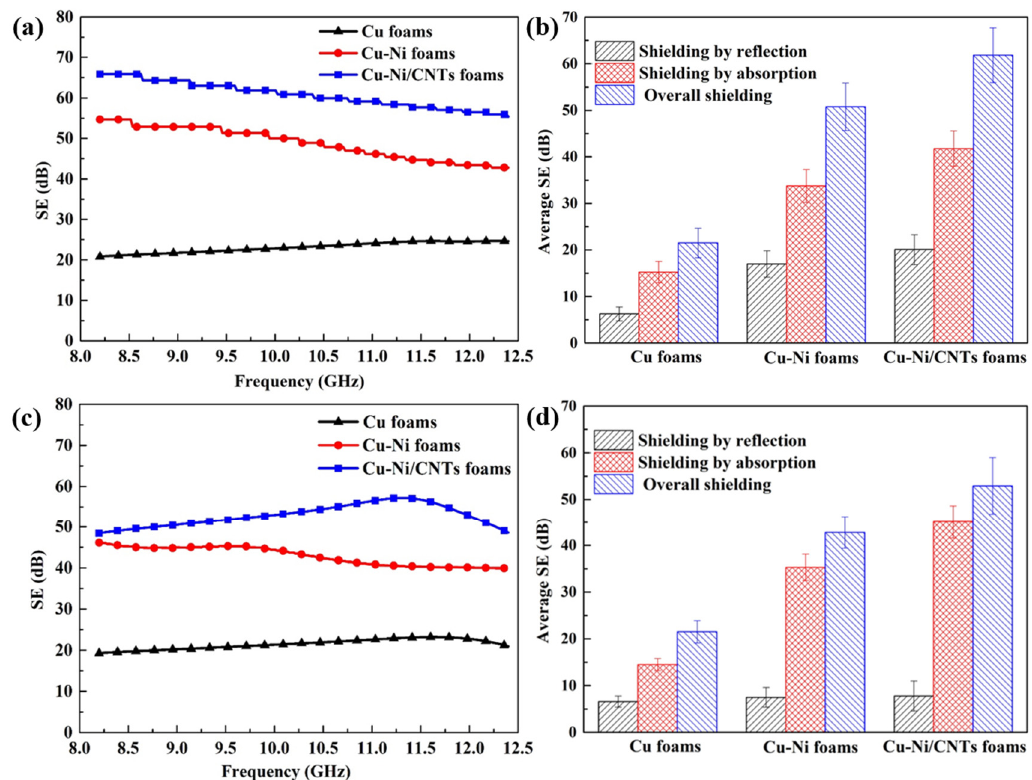
Figure 8. The electromagnetic shielding performance of Cu foams, Cu-Ni foams and Cu-Ni/CNTs foams in the frequency range of 8.2–12.4 GHz; ( a ) SE before heat treatment; ( b ) average EMI SE before heat treatment; ( c ) SE after heat treatment; ( d ) average EMI SE after heat treatment.